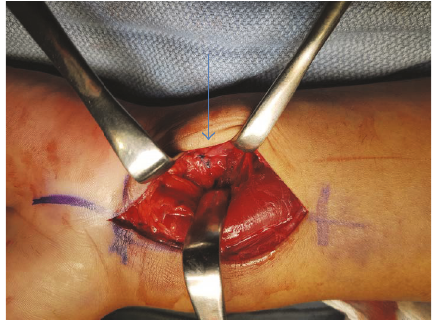
Figure 3: Volar surgical approach showing the volar displacement of the ulna (arrow).